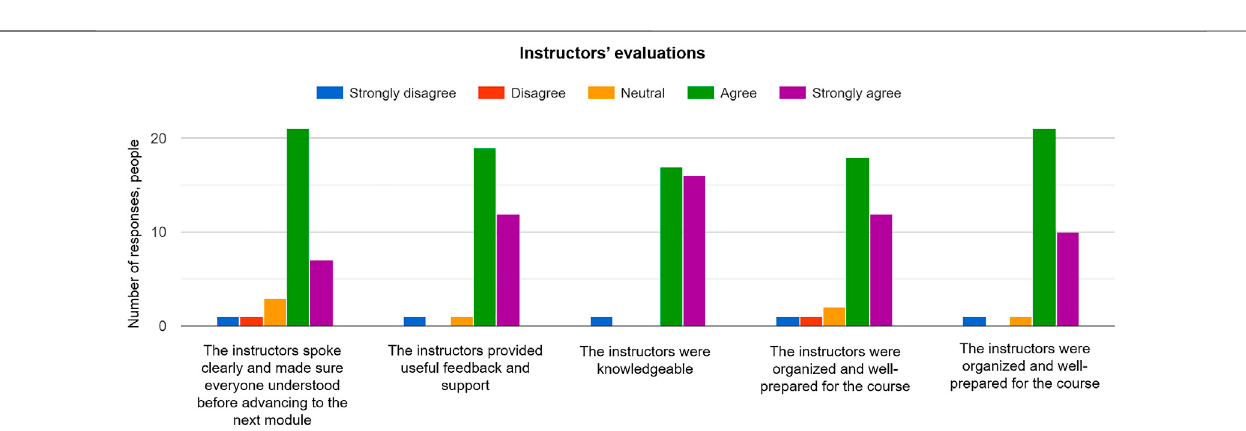
FIGURE 9 | Responses of participants for evaluation of the instructors ’ delivery of the short course.